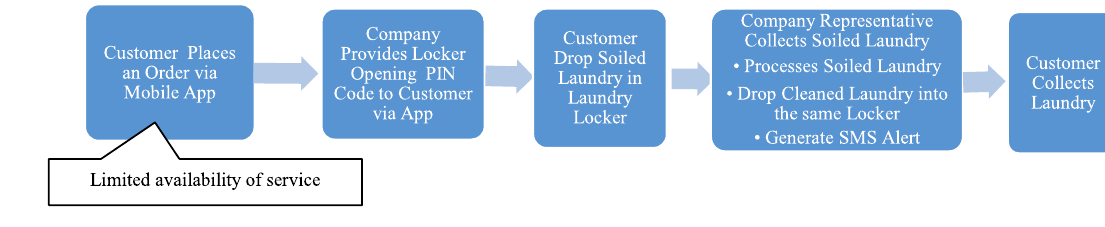
FIG. 4. SPECIALIZED LAUNDRY LOCKERS FOR DROP-OFF AND